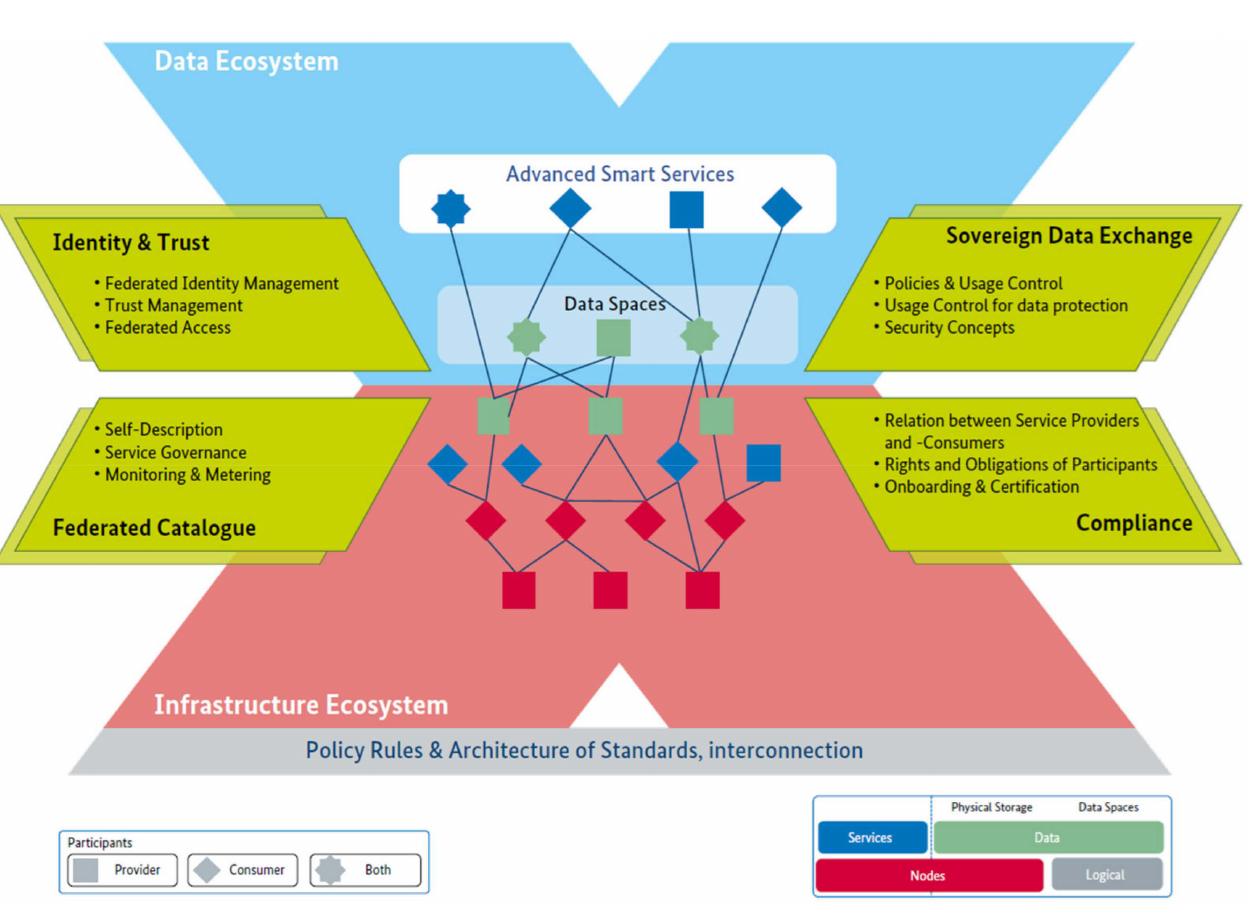
Figure 3. GAIA-X High Level